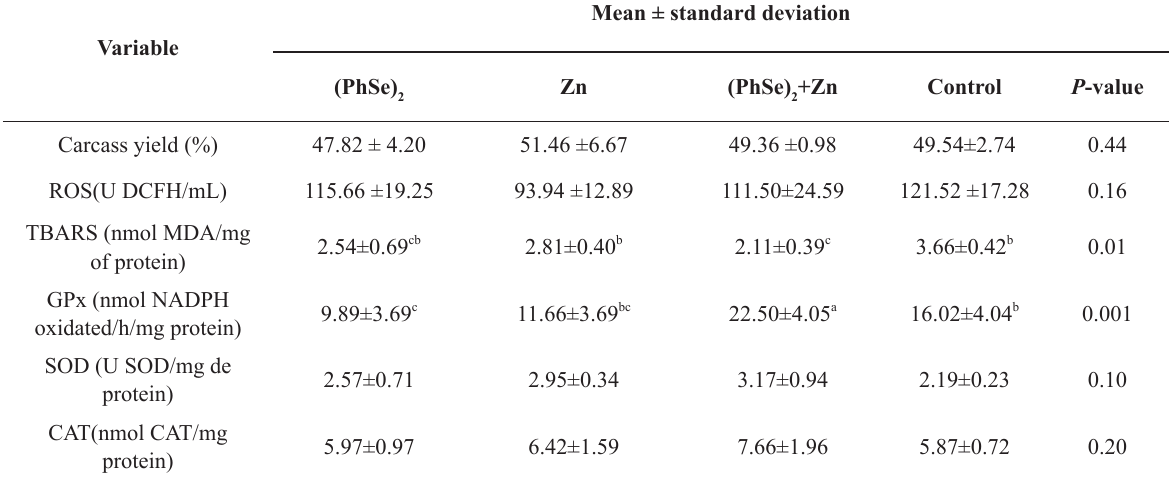
Mean and standard deviation of biochemical muscle tissue for each group at the slaughterhouse, carcass yield, ROS, TBARS, GPx, SOD and